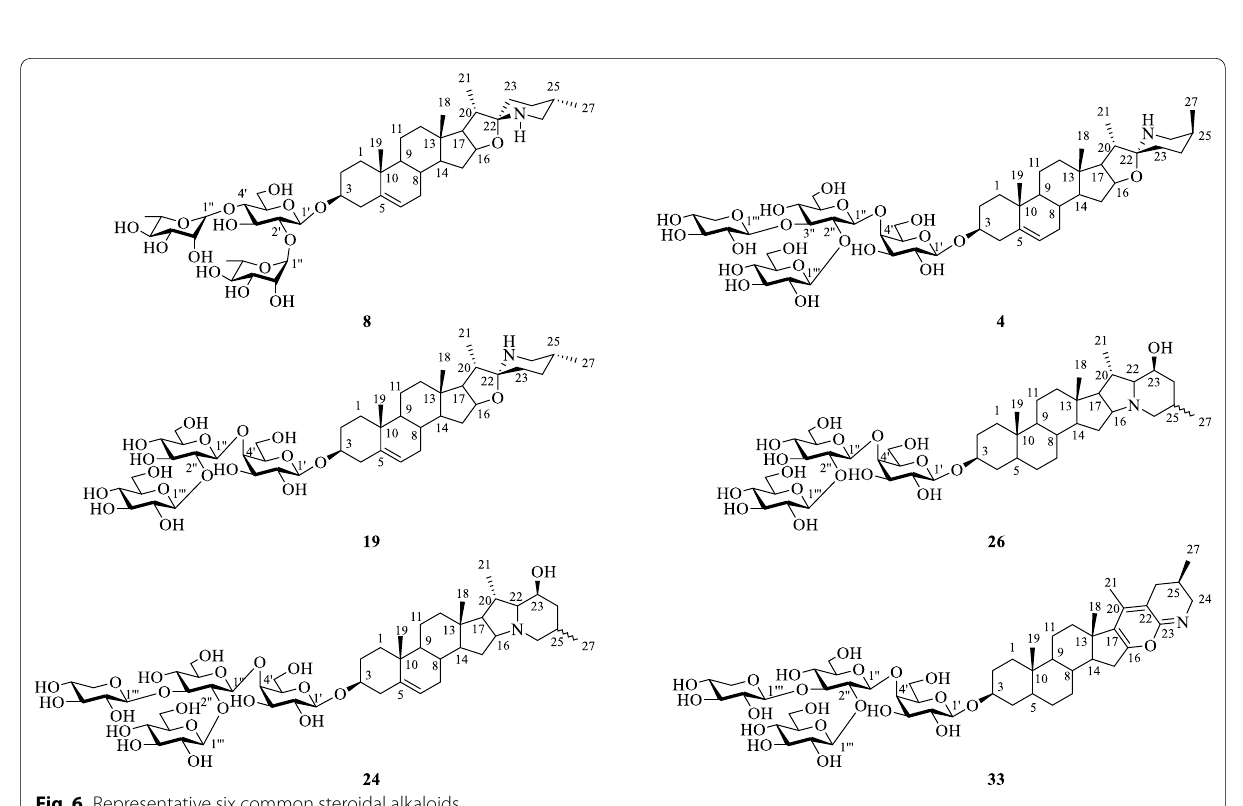
4.4 NMR characteristics of steroidal saponins In short, in the 13 C NMR spectra, spirostanol and furo- stanol-types of steroidal saponins, characterizing a A/B/C/D ring system of C 27 -steroidal scaffold, show twenty-seven carbon signals generally containing four methyl carbon signals at δ C 16.0 (C-18), 19.0 (C-19), 14.0 (C-21), and 17.0 (C-27) or two olefinic carbon signals at δ C 140.0 (C-5) and 120.0 (C-6) [47, 49] (Table 6 and Fig. 11). The carbon chemical shift of CH 3 -19 will down- field shifted from δ C 12.0 to δ C 19.0 [47, 49], when the two methylenes at C-5,6 being dehydrogenated (-H 2 ) to form a double bond [53]. The carbon resonances of C-16, 17, 22 (spiroketal carbon) and C-26 in a spirostanol-type steroidal saponin, were at about δ C 81.0, 62.0, 109.0 and 67.0, respectively [47, 49], while those in a furostanol- type steroidal saponin were at about δ C 81.0, 64.0, 112.0